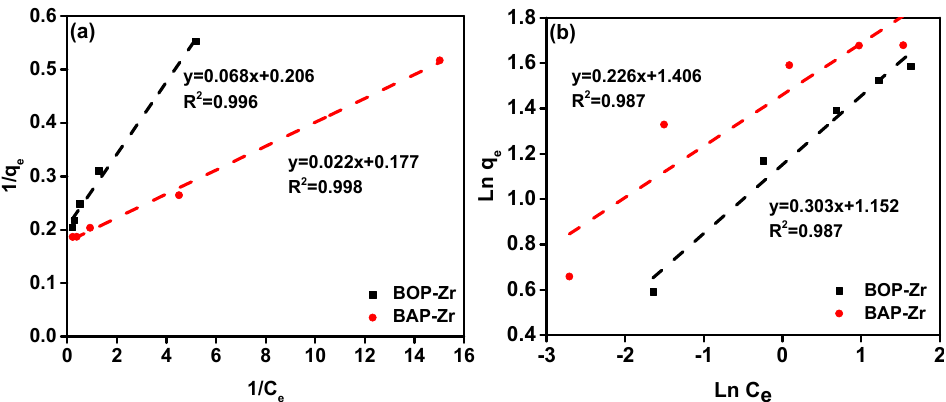
Figure 7. Adsorption isotherms for the bioadsorbents by using the models of ( a ) Langmuir, and ( b ) Freundlich. The black and red dashed-lines represent their respective linear fit. Table 2. Summary of parameters for the Langmuir and Freundlich models obtained for the bioadsorbents.